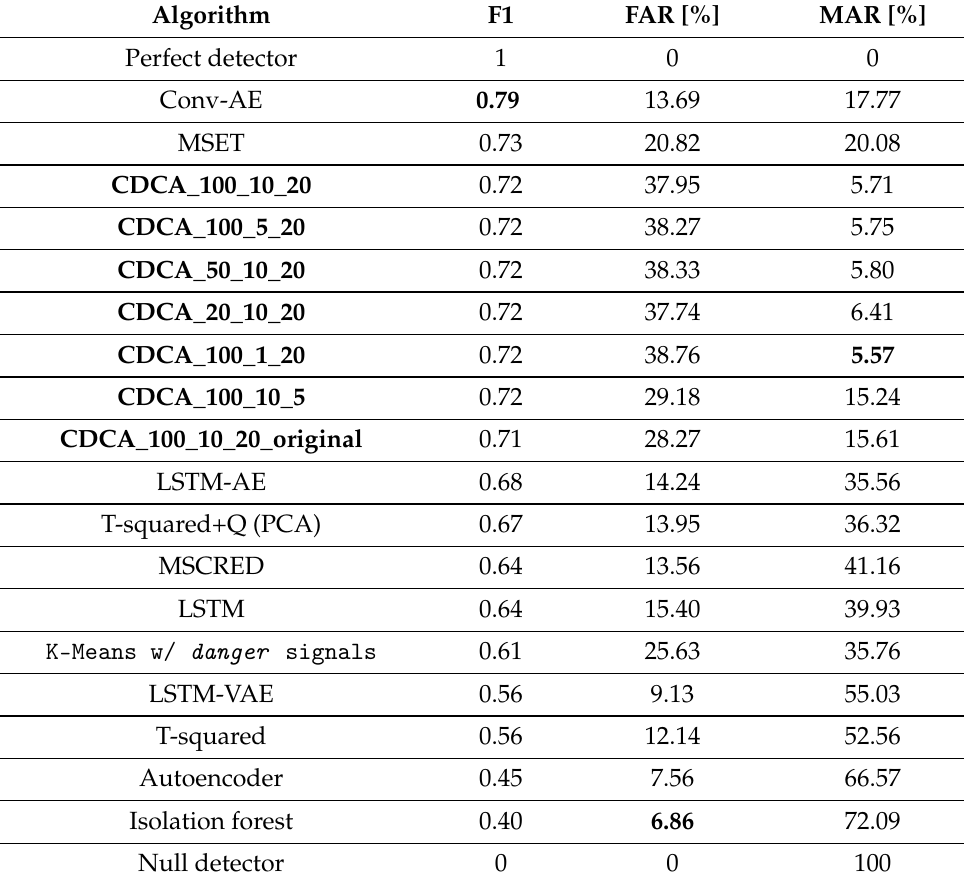
Table 1. Results for all existing algorithms in SKAB and the Cursory Dendritic Cell Algorithm (DCDA) with different parameter’s range, as well as the adapted version of K-Means. Results for CDCA and K-Means are an average of the results of 10 repeated test instances.